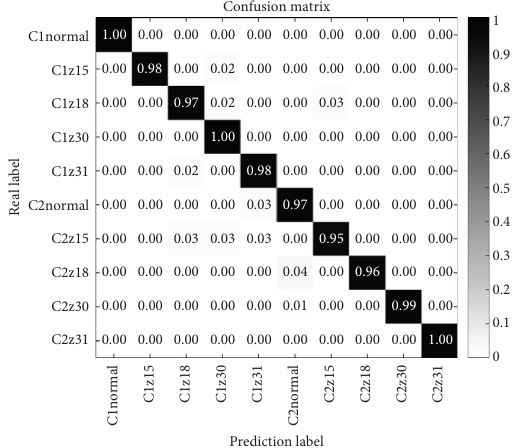
Figure 15: t-SNE visualization of characteristics. Figure 16: Confusion matrix of classifcation